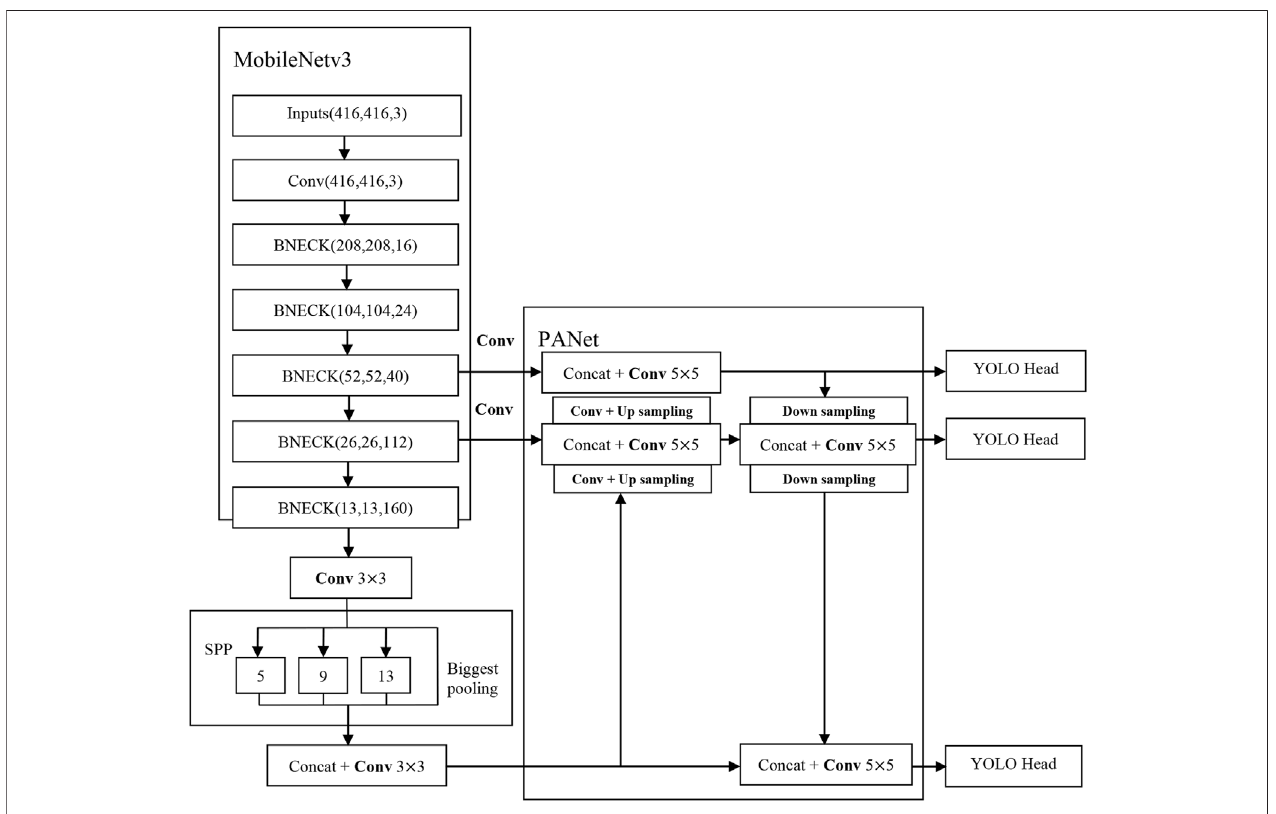
FIGURE 3 | Schematic diagram of YOLOv4-Lite.